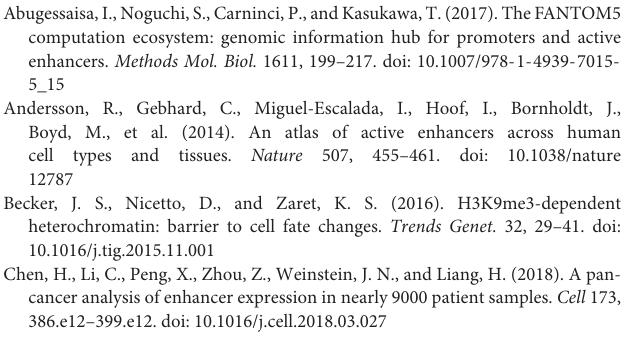
TABLE S5 | Enhancers regulating miRNA associated with known transcription of enhancers in distal regulation. TABLE S6 | Enhancers regulating miRNA associated with known transcription of enhancers in proximal